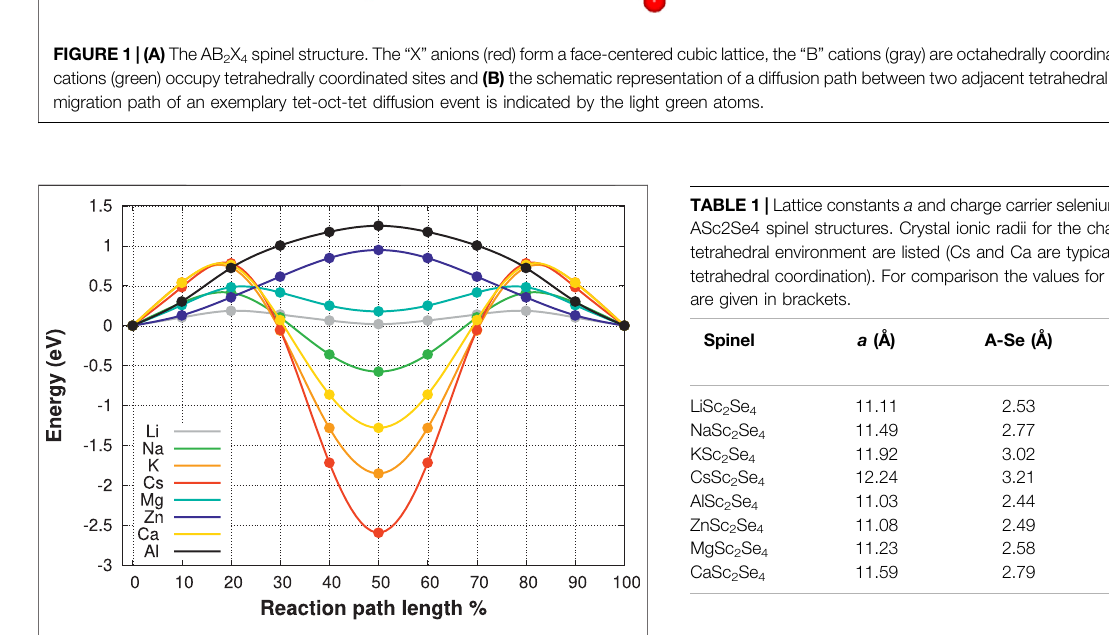
FIGURE 2 | The tet-oct-tet migration of possible charge carriers in the fi xed MgSc 2 Se 4 spinel structure without ionic relaxation. The energies are taken relative to the energy of the charge carrier in the tetrahedral coordination.